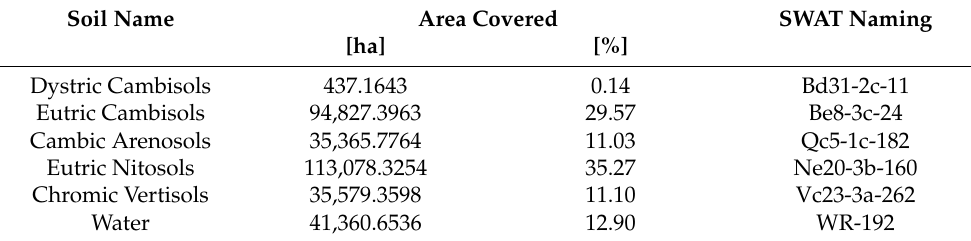
Table 2. Soils that are present in the Fincha’a